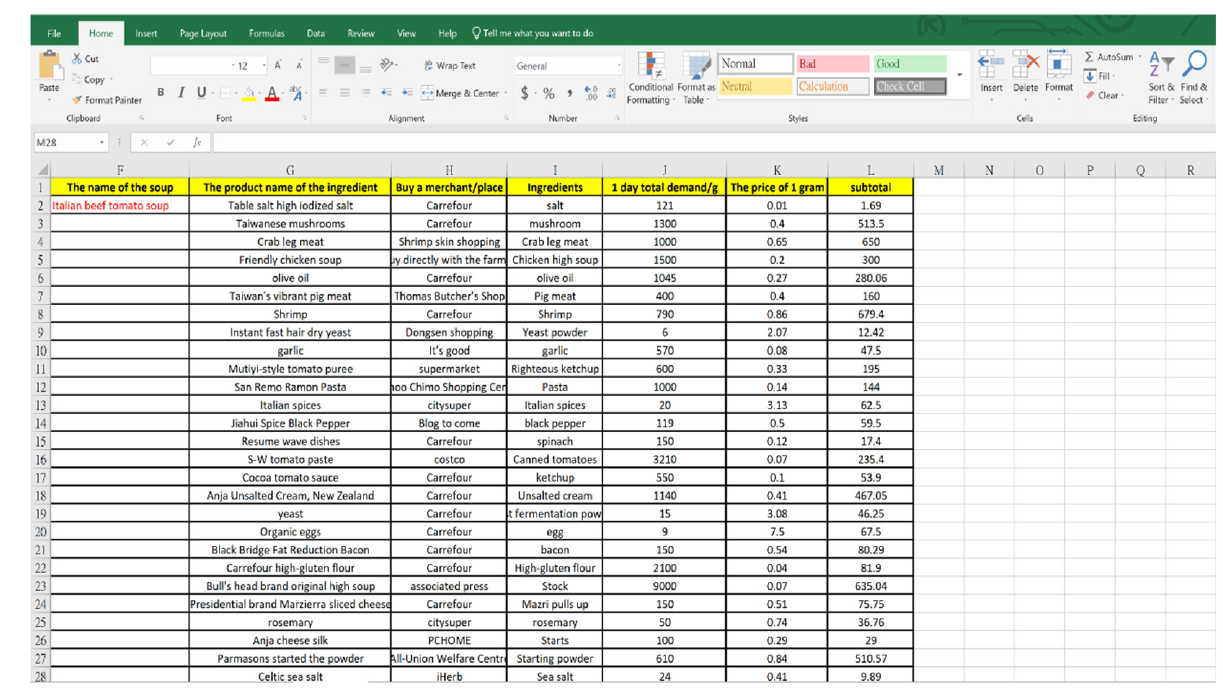
Figure 1. Microsoft Excel system in Culinary and Restaurant Management course.